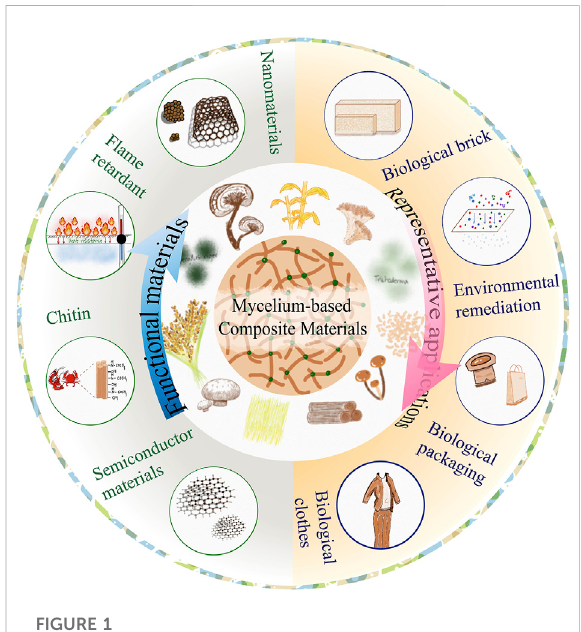
FIGURE 1 Comprehensive overview of mycelium-based composites (composite functional elements made with biomaterials to improve their biological properties and